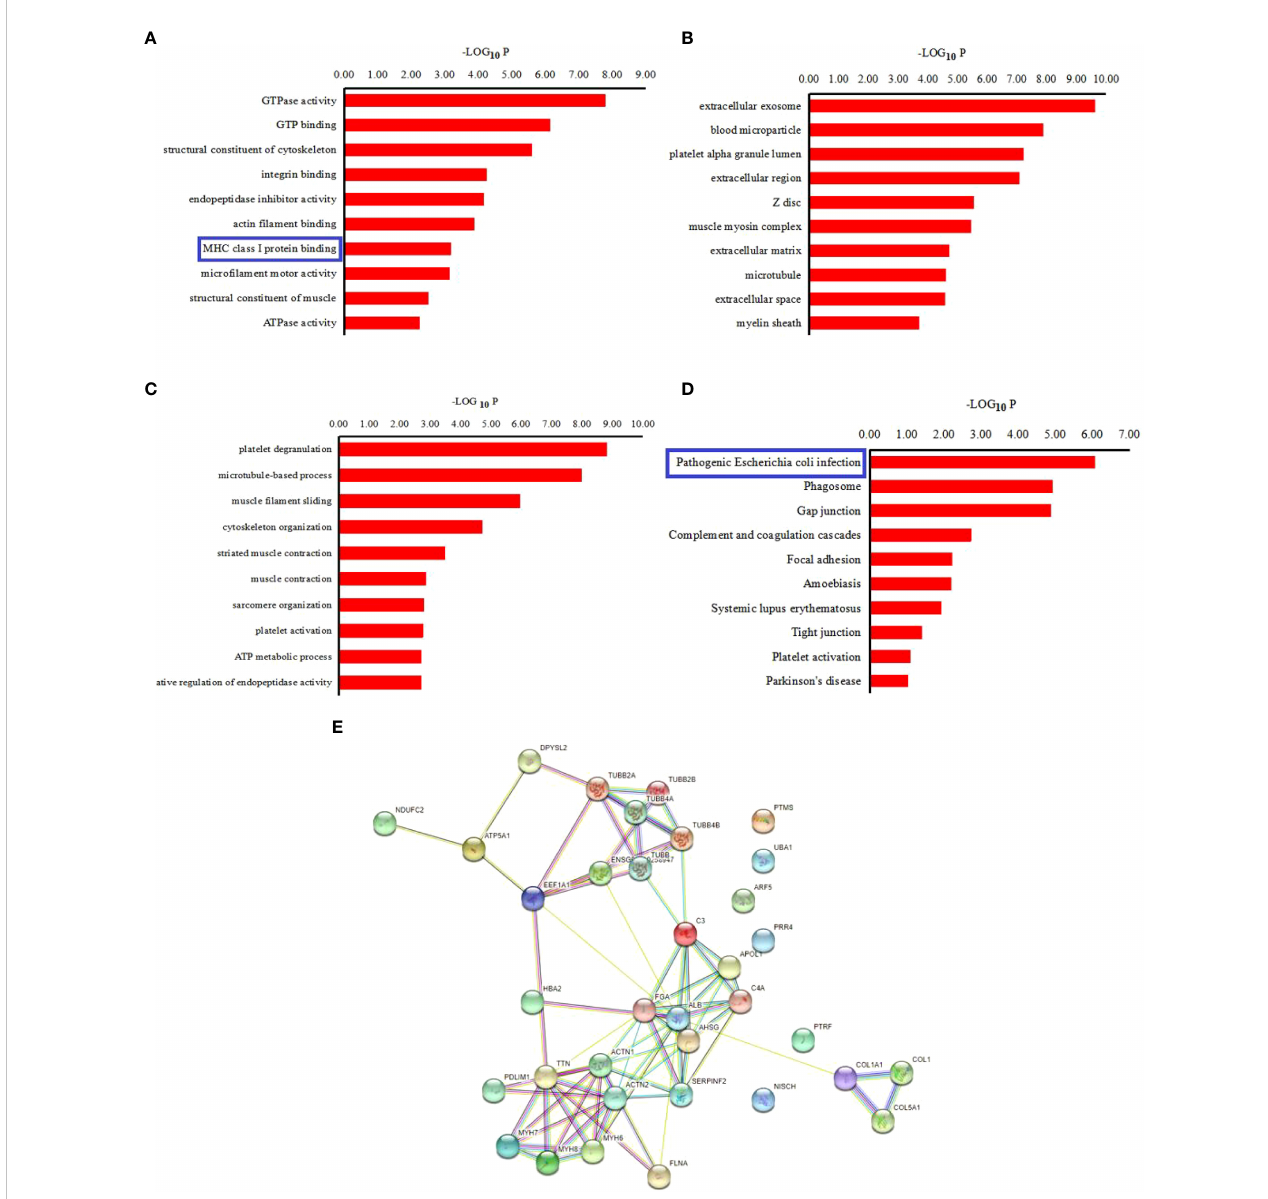
FIGURE 3 Bioinformatics analysis of pepetide precursor proteins: Gene ontology of 9 (A) Biological process of differentially expressed peptides precursor proteins. (B) Cellular components of differentialy expressed peptides precursor proteins. (C) Molecular function of differentially expressed peptides precursor